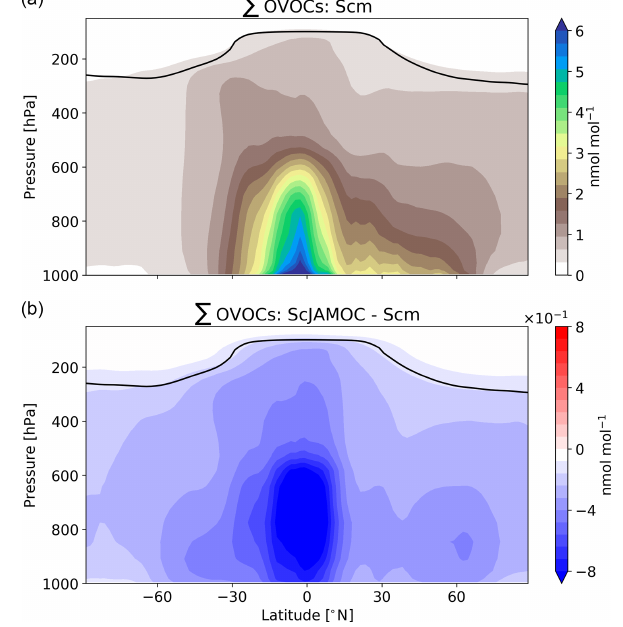
Figure 3. Yearly zonal mean mixing ratio of the sum of all the OVOCs explicitly reacting in JAMOC ( (cid:80) OVOCs; see Eq. A1 in Appendix A) for Scm (a) and in comparison to ScJAMOC (b) . The characteristics of each simulation are provided in Table 1. The yearly mean tropopause is depicted by a black line.